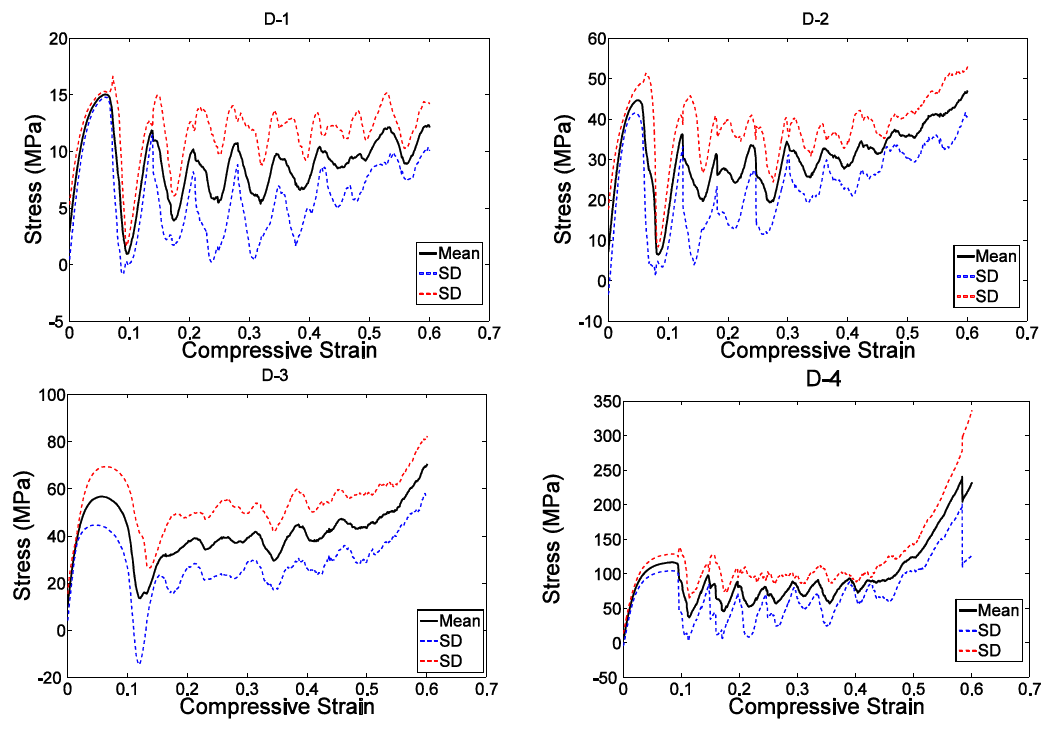
Figure 4. Stress-strain curves for specimens based on the diamond unit cell and with different porosities (see Table